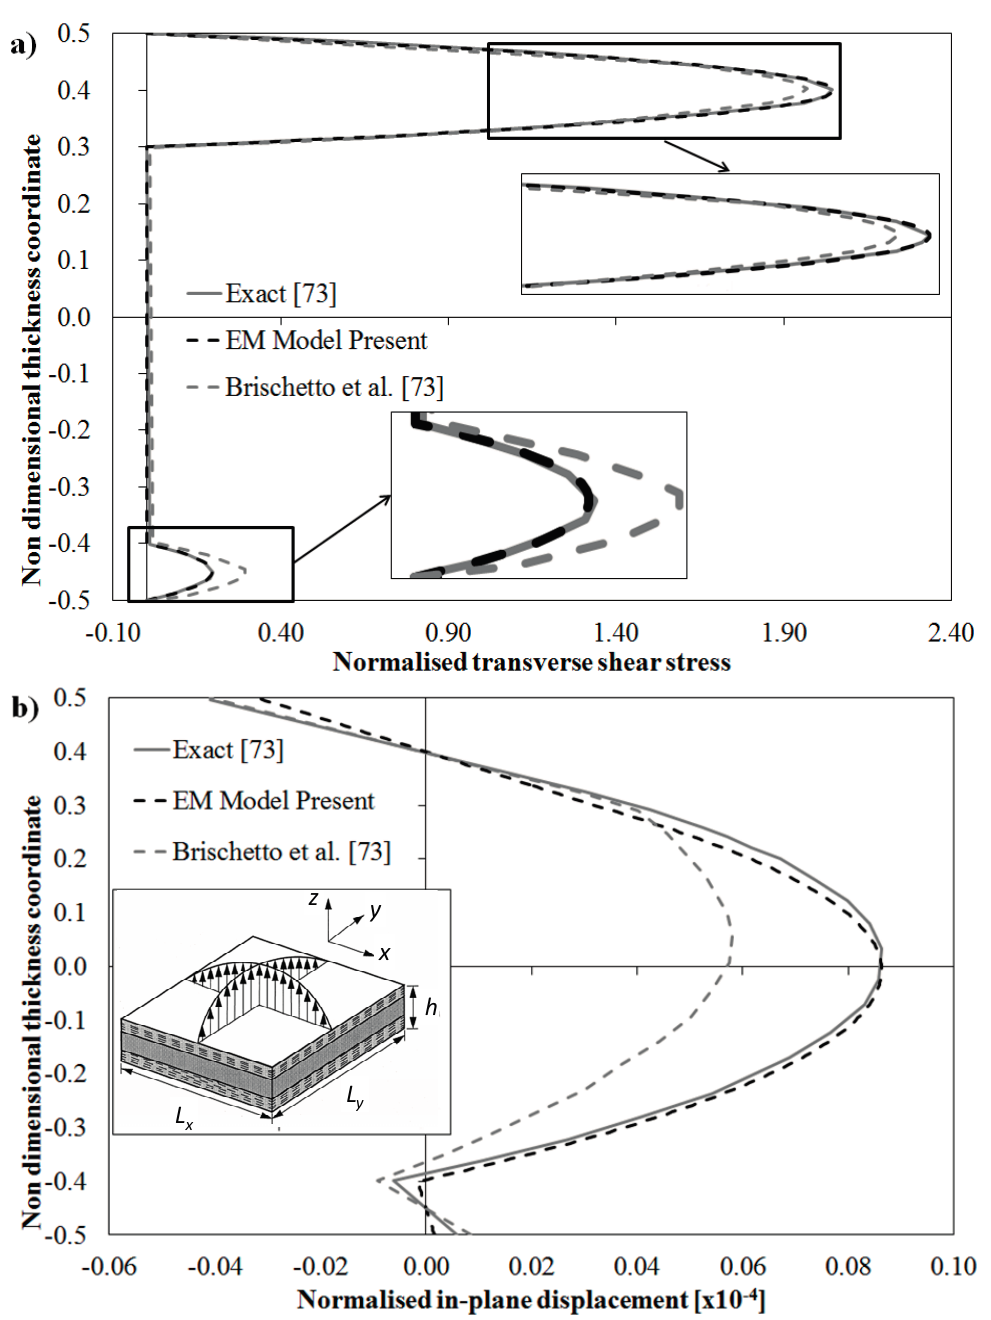
Figure 5. Exact solution and through-the-thickness distribution of: ( a ) normalized transverse shear stress and ( b ) normalized in-plane displacement by the model [73] and by the present EM model for a sandwich